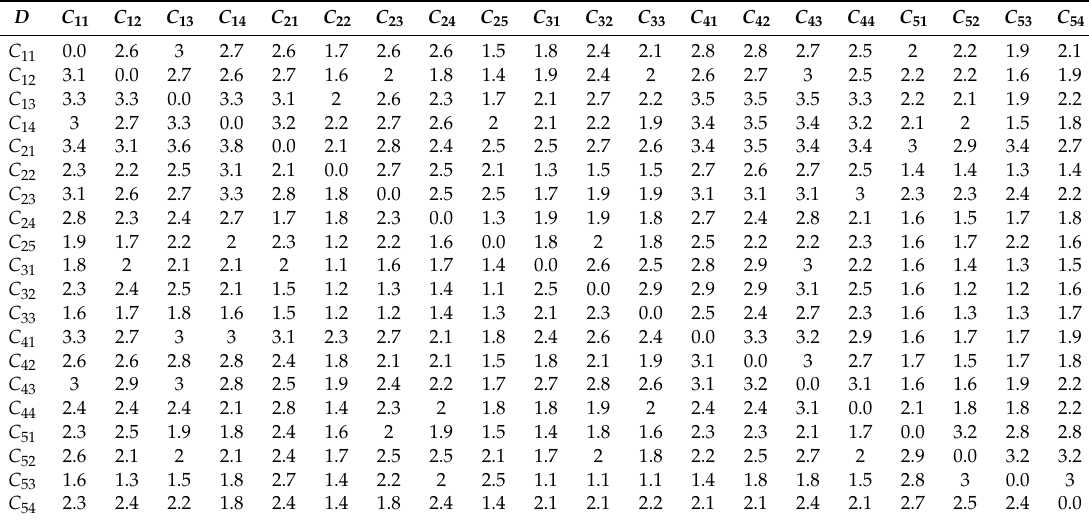
Table A1. Average direct influence relation matrix D